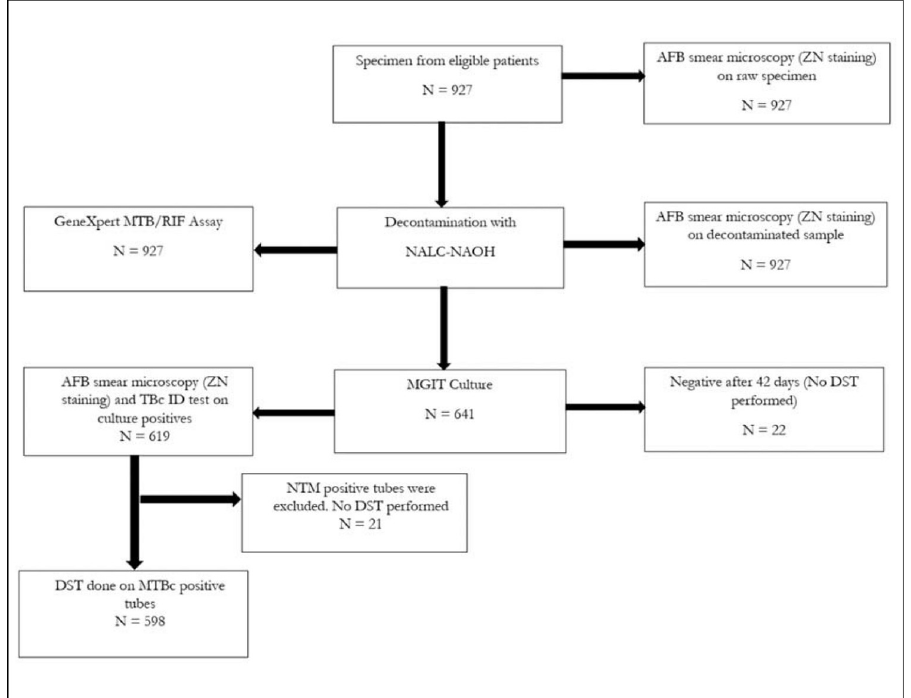
Fig 1. Flow chart describing the bacteriological confirmation of sputum samples received from patients included in the survey (ZN: Ziel Neelson; MTB/RIF: Mycobacterium tuberculosis /Rifampicin; NALC-NAOH: N-Acetyl- L-Cysteine-Sodium-Hydroxide; AFB: Acid Fast Bacillus; MGIT: Mycobacterium Growth Indicator Tube; DST: drug susceptibility testing; NTM: Nontuberculous mycobacterial; MTBC: Mycobacterium tuberculosis complex.